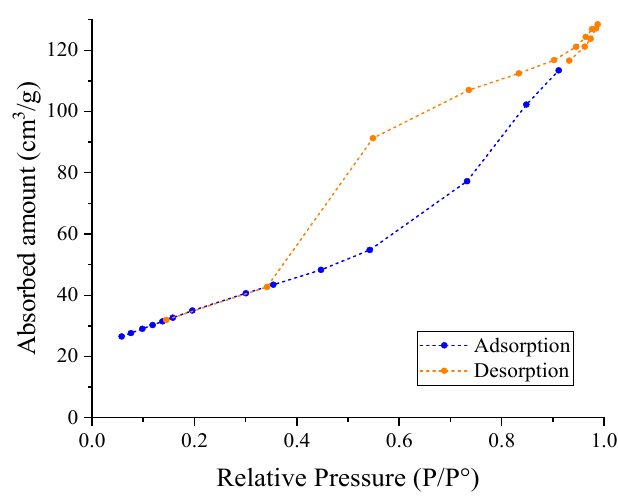
Figure 12. Isotherm absorption-desorption of the modified catalyst SL400.